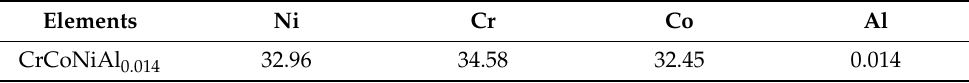
Table 1. Chemical composition of CrCoNiAl 0.014 alloy.